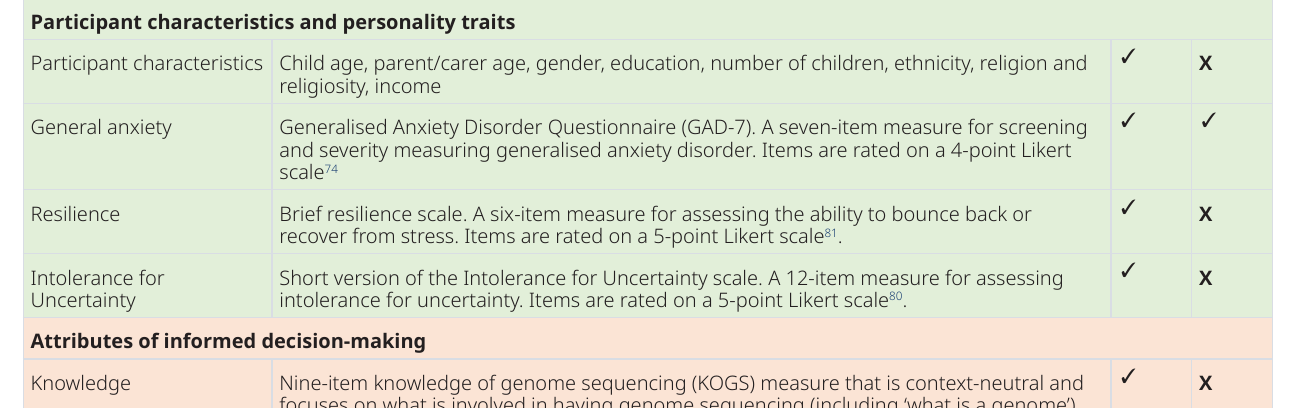
Table 1. Summary of survey measures. Survey domain Description Time 1 Time 2 Participant characteristics and personality